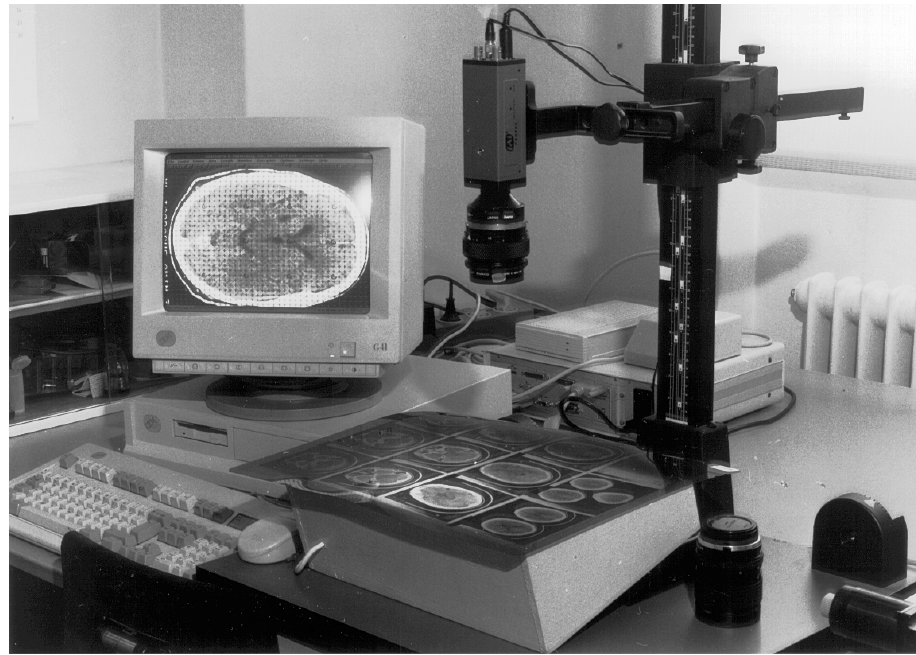
Fig. 1. Shows a video camera that transfers the polaroid pictures to a video-screen. A counting grid is superimposed on the screen with a random position, and all points hitting the third plus the lateral ventricles are